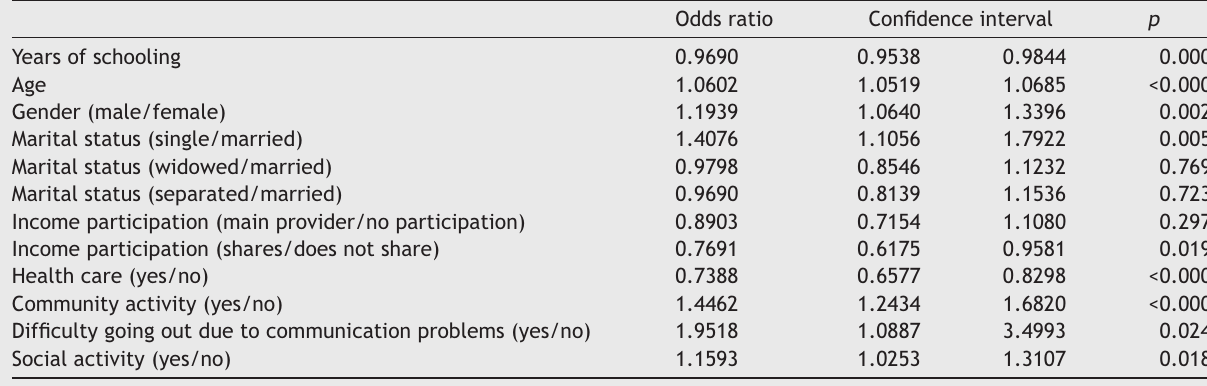
Results of multiple logistic regression for the chance of having hearing loss complaints.